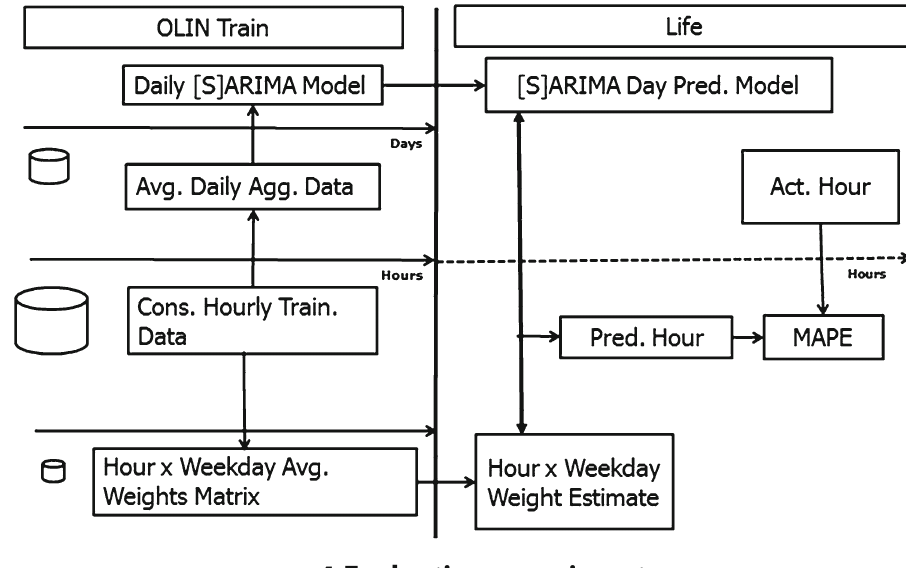
Fig. 3 SWDP[2]SA flowchart algorithm